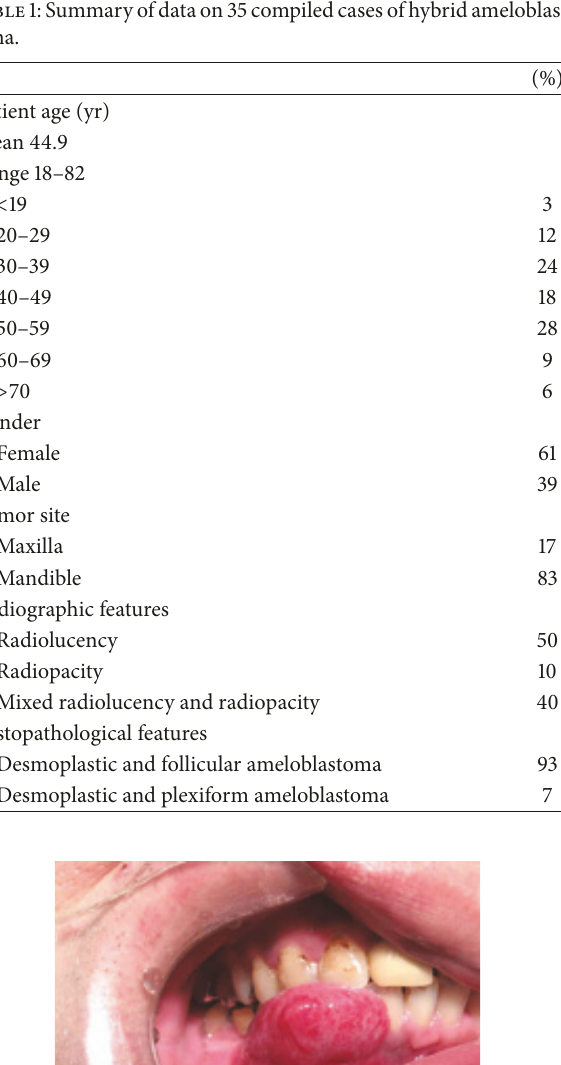
Table1:Summaryofdataon35compiledcasesofhybridameloblas-